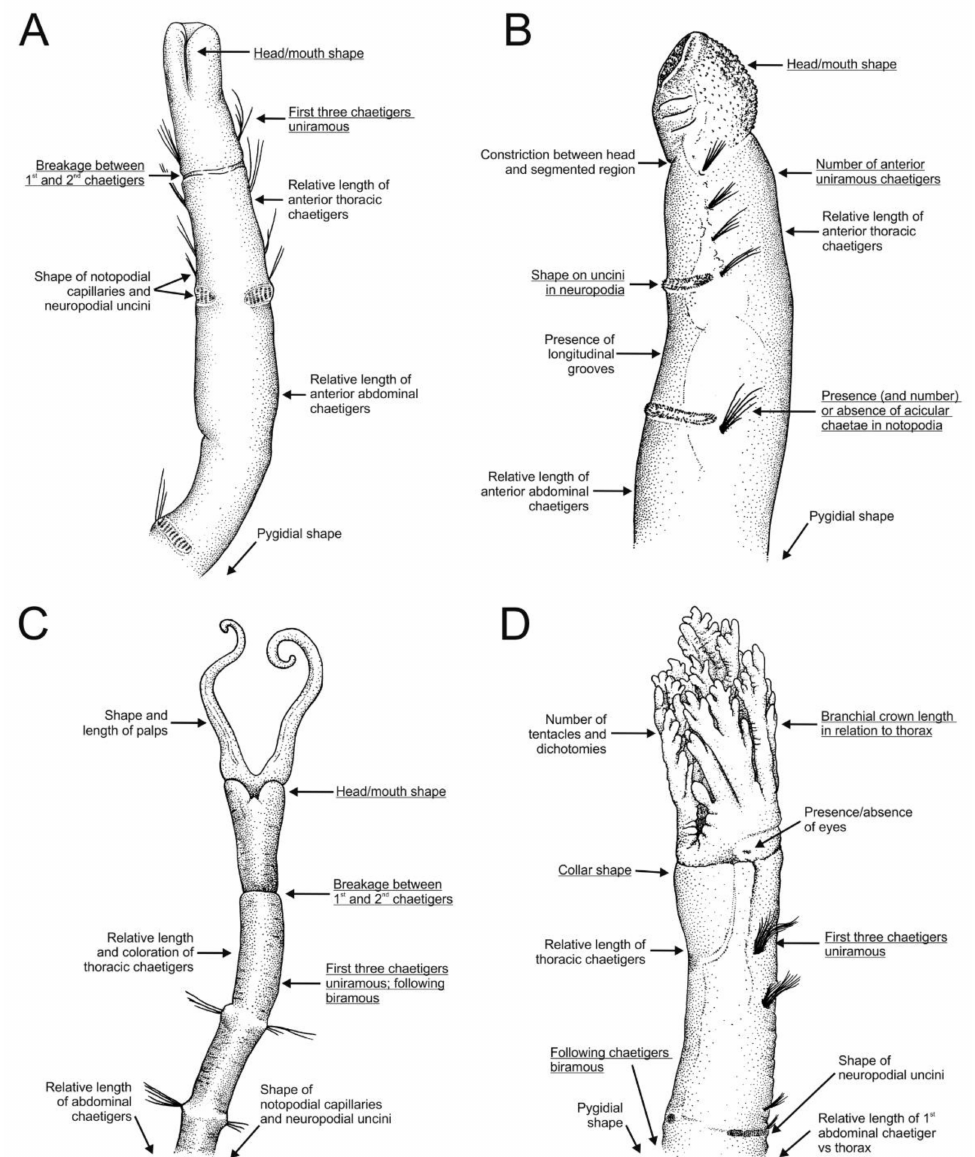
Figure 15. Stylised drawings of anterior region of representative species of all Oweniidae genera showing main diagnostic characters both of genus (underlined) and species. ( A ) Galathowenia quelis Capa, Parapar and Hutchings, 2012 in ventral view; ( B ) Myriochele australiensis Hartman, 1955 in lateral view; ( C ) Myriowenia sp. in ventral view; ( D ) Owenia australis Ford and Hutchings, 2005 in ventro-lateral view. (A) Redrawn after Parapar and Moreira ([78]; ( B ) after Blake [71]; ( C ) after Hartman [95]; ( D ) after Ford and Hutchings